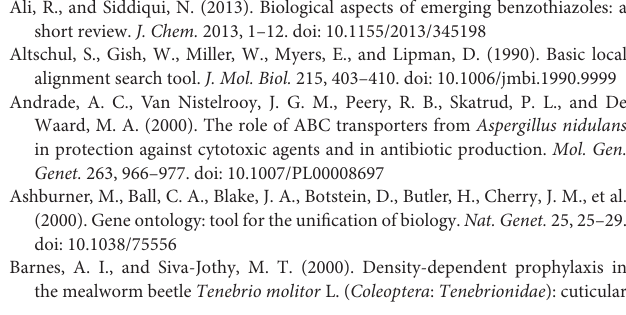
TABLE S7 | Annotations of unigenes from seven public